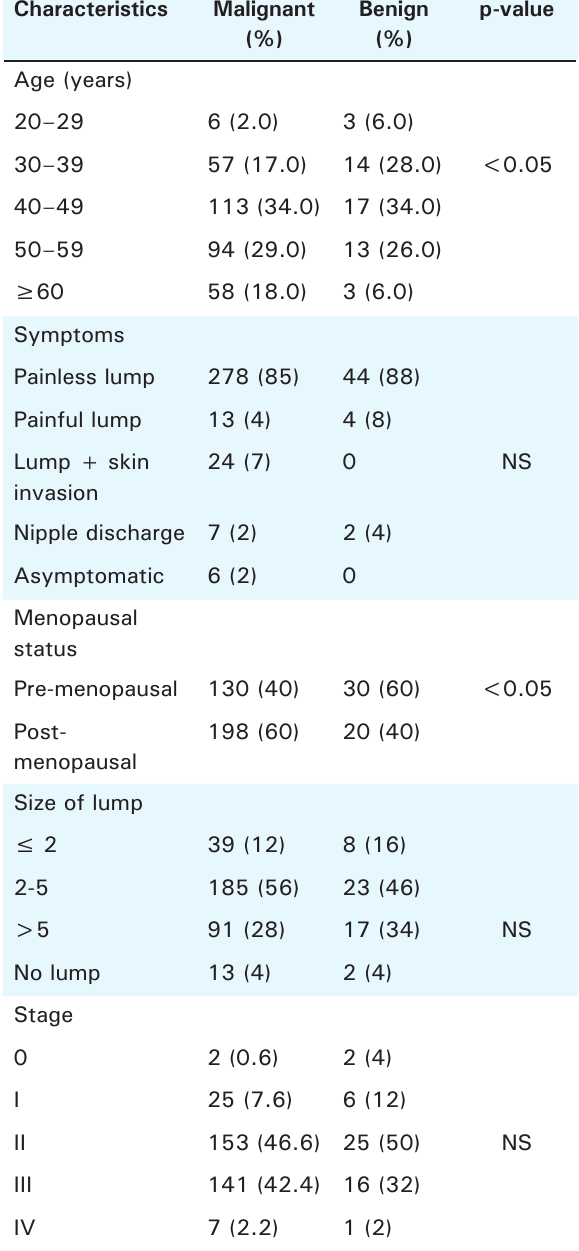
table 3. characteristics of women with histologically proven breast carcinoma who underwent ammography